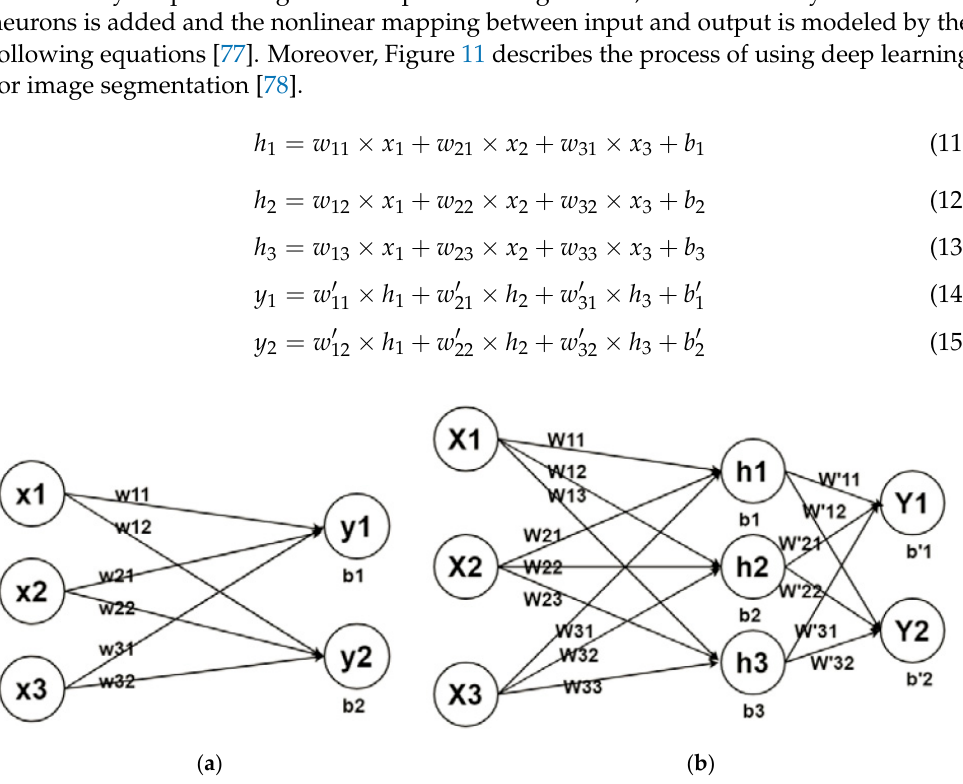
Figure 10. Explanation of the difference between a linear regression model and a simple learning model: ( a ) linear model regression model; ( b ) simplified deep learning model [77].